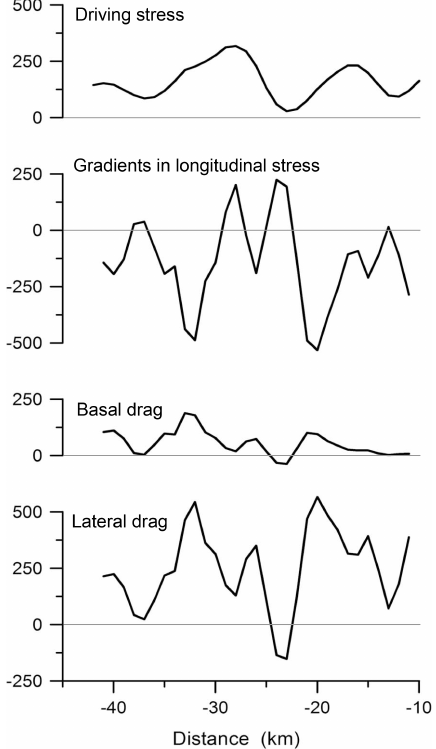
Figure 2. Force-balance terms on Byrd Glacier according to geo- metric force balance, Eqs.